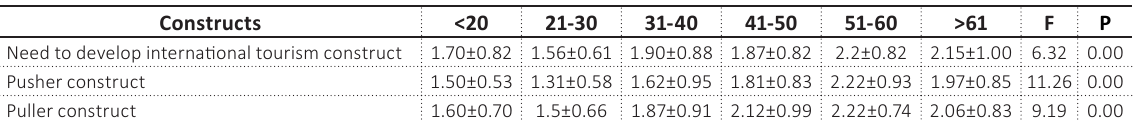
Table 8. Age difference analysis